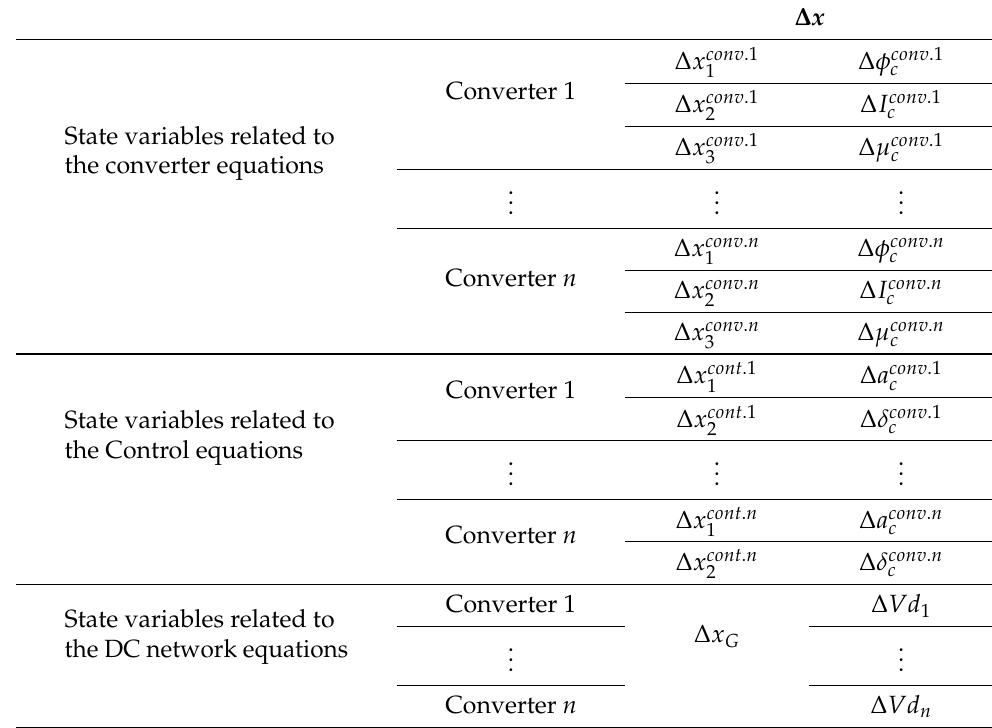
Table 2. Vector of state variables related to the High Voltage Direct Current (HVDC) system ( ∆ x